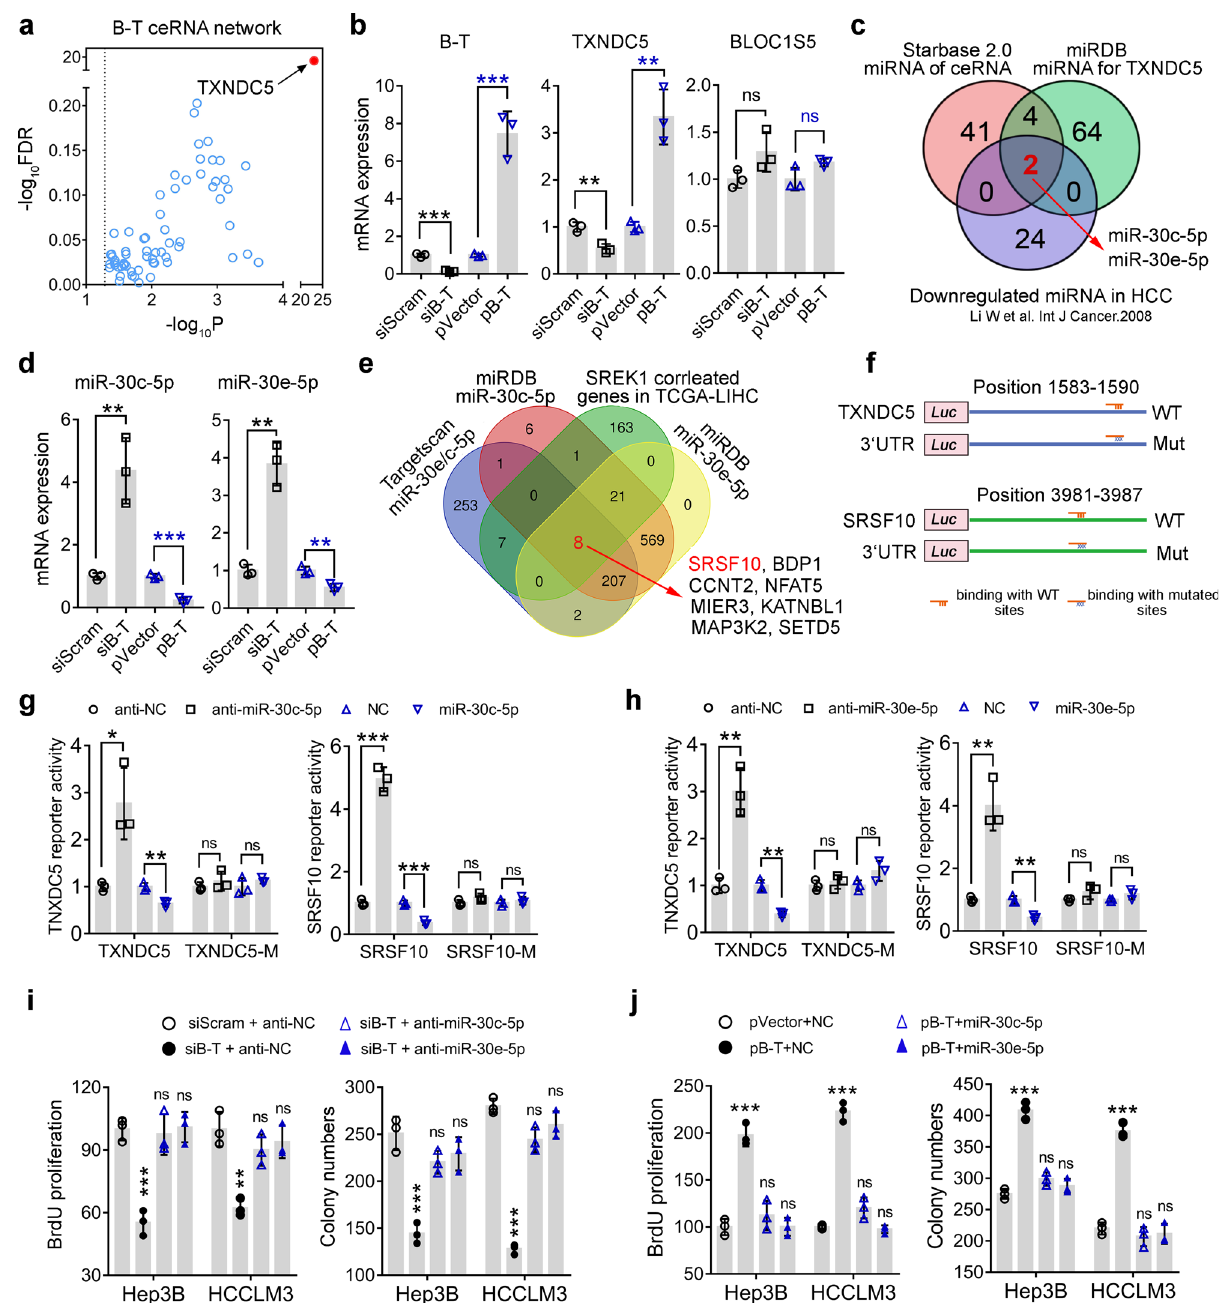
Fig. 4 B-T plays its oncogenic role through acting as a ceRNA to inhibit miR-30c-5p and miR-30e-5p and to promote the expression of TXNDC5 and SRSF10 in HCC cells. a The ceRNA plot analysis of B-T was shown by StarBase v2.0 based on the P and FDR value of the potential targets. b The real-time PCR analysis of the targeted genes after the knockdown or the forced expression of B-T in Hep3B cells. c Venn diagram analysis of the potential downstream microRNAs of B-T acting as a ceRNA in HCC. d The real-time PCR analysis of the effect of silenced or forced expression of B-T on targeted microRNAs ’ expression in Hep3B cells. e Venn diagram analysis of the common downstream targets of miR-30c-5p and miR-30e-5p correlated with SREK1 expression in HCC. The SRSF10 was identi fi ed and scored as the top 1 candidate. f The four 3 ’ -UTR luciferase reporter constructs were presented with WT or mutated corresponding microRNAs binding sites. The effect of the inhibition or mimics expression of the g miR-30c-5p or h miR-30e-5p on WT or mutated corresponding 3 ’ -UTR reporters ’ activity of TXDNC5 or SRSF10 in Hep3B cells. The BrdU proliferation or colony formation analysis of the Hep3B or HCCLM3 cells treated i by B-T knockdown or its combined knockdown with miR-30c-5p or miR-30e-5p, or j by forced B-T expression or the combined expression of B-T with miR-30c-5p or miR-30e-5p. N = 3, mean ± SD, two-tailed, unpaired t test is used for ( b , d , g – j ), * p < 0.05; ** p < 0.01; *** p < 0.001; ns indicates non-signi fi cant. Source data are provided as a Source Data fi le.